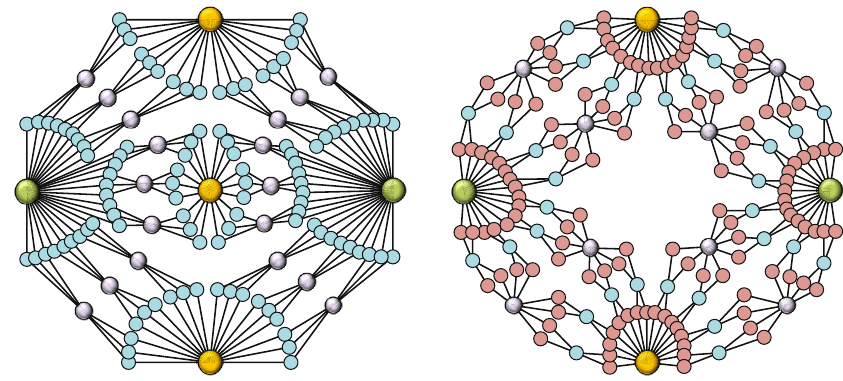
Figure 2: Illustration for two networks ( ) G 3, 1, 3 and ( ) G 2, 1, 4